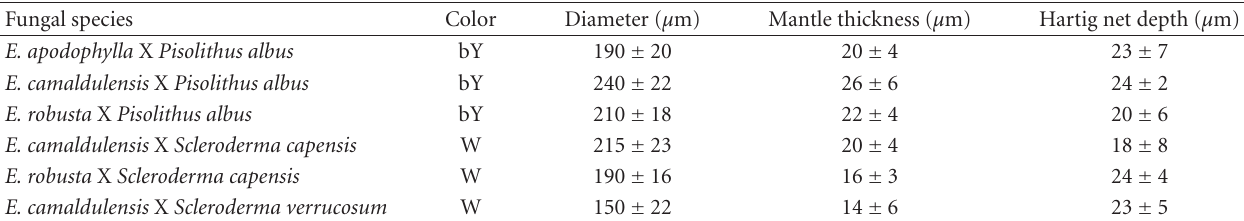
Table 2: Color, diameter, fungal mantle thickness, and Hartig net depth of ectomycorrhizae in situ collected in Senegal on 3 species of Eucalyptus